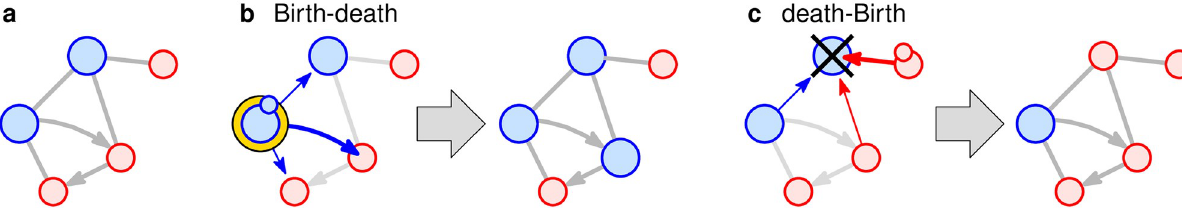
Fig 1. Moran process on graphs. a , The spatial structure is represented by a graph. Each vertex represents a site and is occupied either by a resident (red) with fitness 1 or by a mutant (blue) with relative fitness r > 1. Each edge can be one-way (arrow) or two-way. b , In each step of the Birth-death process, one individual is sampled for reproduction proportionally to fitness, and then its offspring replaces a random neighbor. c , In each step of the death-Birth process, a random individual dies and then it is replaced by a neighbor sampled proportionally to